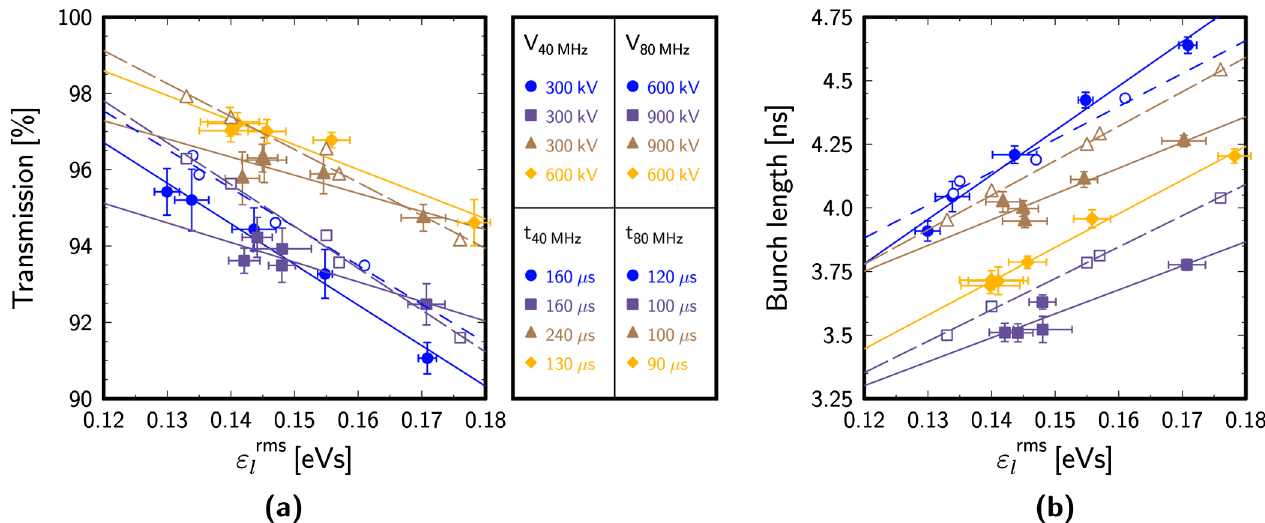
FIG. 6. Emittance dependence of transmission (a) and bunch length (b). Full and empty markers (continuous and dashed lines) mark experimental and simulation results, respectively. The blue circles correspond to currently operational settings, the violet squares to earlier optimization attempts based on bunch length. The brown triangles and the yellow diamonds show the results using optimized timings and additional V 80 MHz or V 40 MHz , respectively, for the rotation. No simulations were done for the latter case. The bunch length is obtained from a 4 (cid:1) Gaussian fit in all